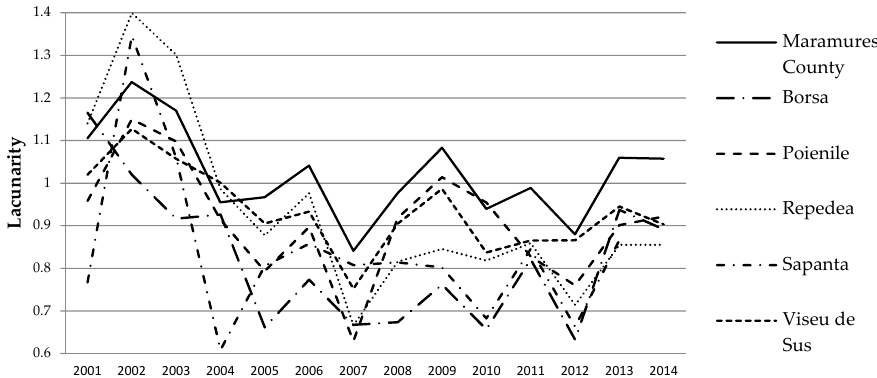
Figure 5. Temporal evolution of FG2DL (Fixed Grid 2D Lacunarity) (2000–2014) at the county and TAU levels.